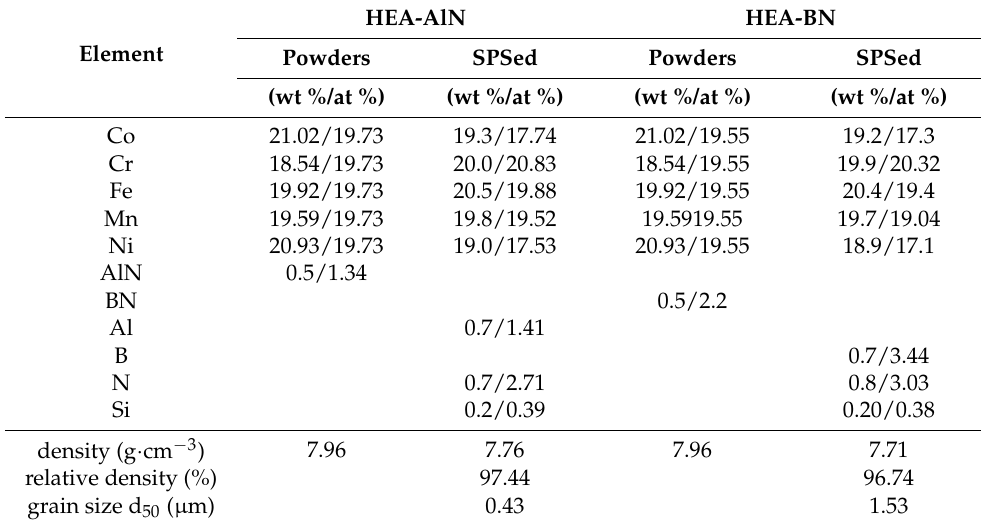
Table 1. Compositions of powders used for alloy preparation and of the final compacts after spark plasma sintering. The densities of powders and compacts are shown in the lower part of the table.